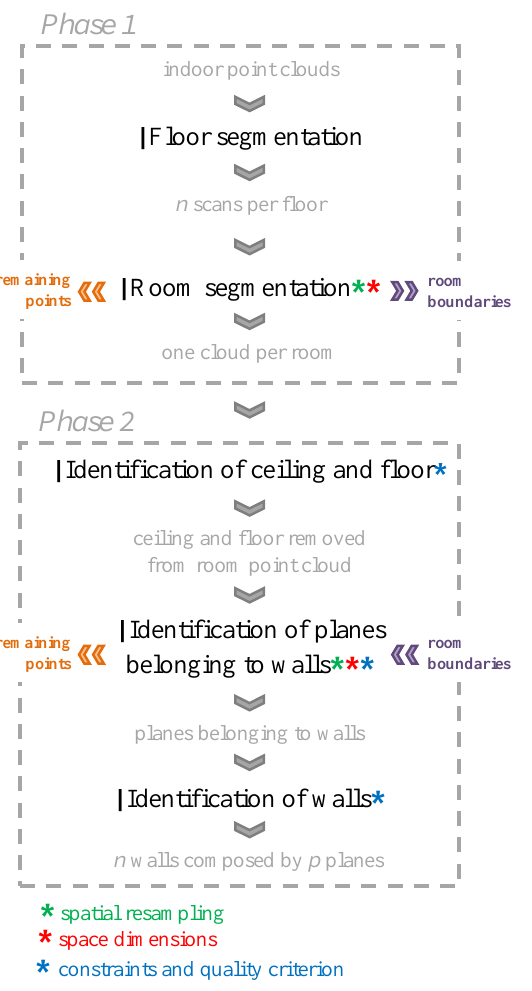
Figure 1. Organisation chart of the developed